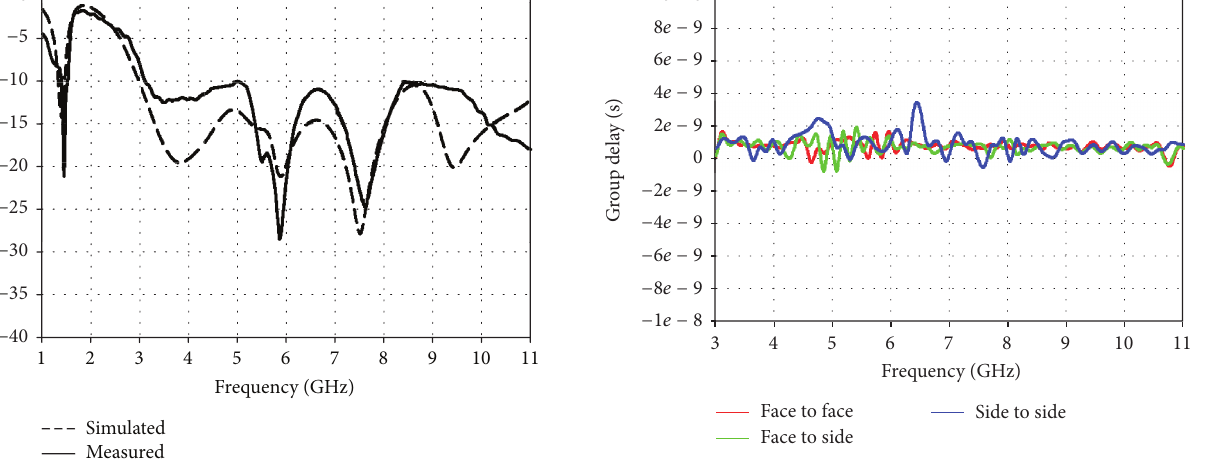
Figure 5: Measured group delay of the proposed antenna for different orientations.